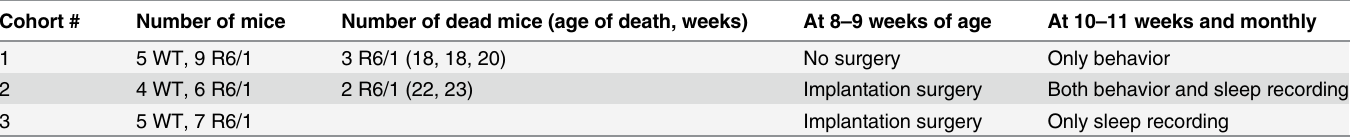
Table 1. Three cohorts of R6/1 and littermate mice